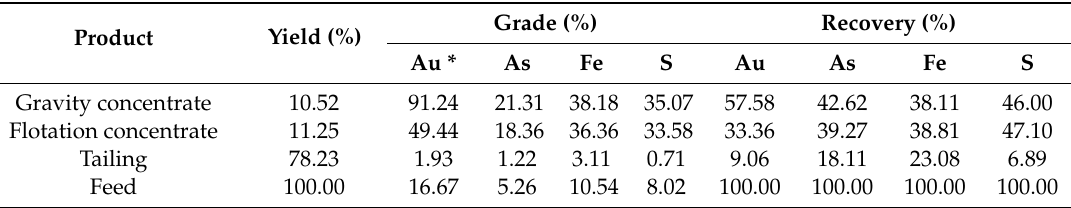
Table 5. The results of the closed-circuit